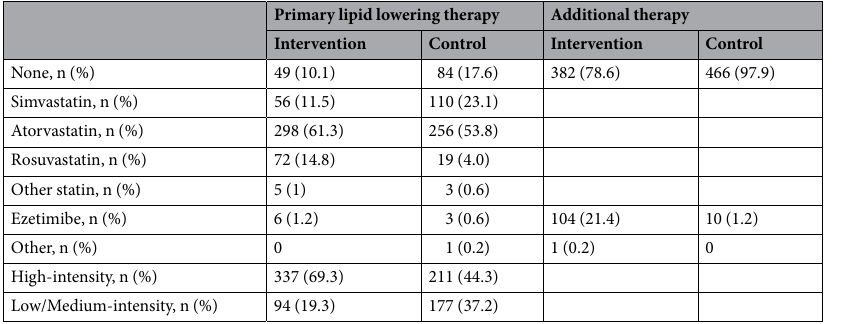
Table 3. Type of lipid-lowering treatment at end of follow-up. High-intensity: lipid-lowering therapy (simvastatin > 40 mg, atorvastatin ≥ 40 mg or rosuvastatin > 10 mg); Low/Medium-intensity: not fulfilling the